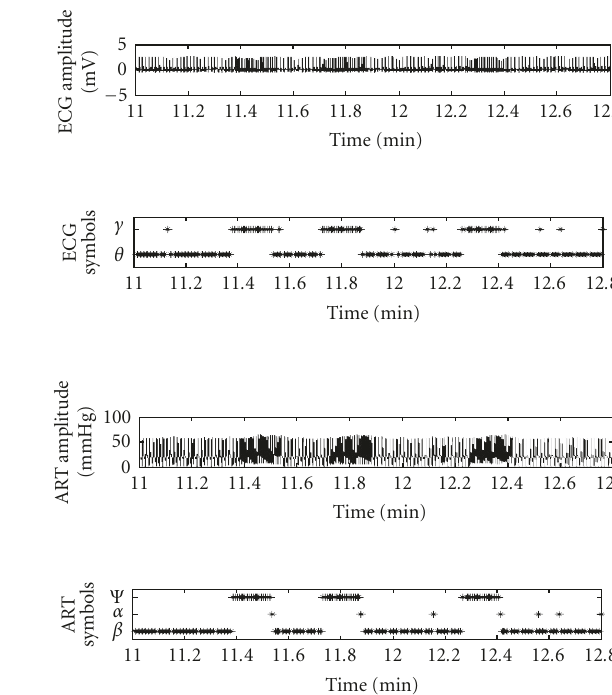
Figure 15: ECG and arterial blood pressure signals for a patient in whom fast heart rate leads to increased arterial blood